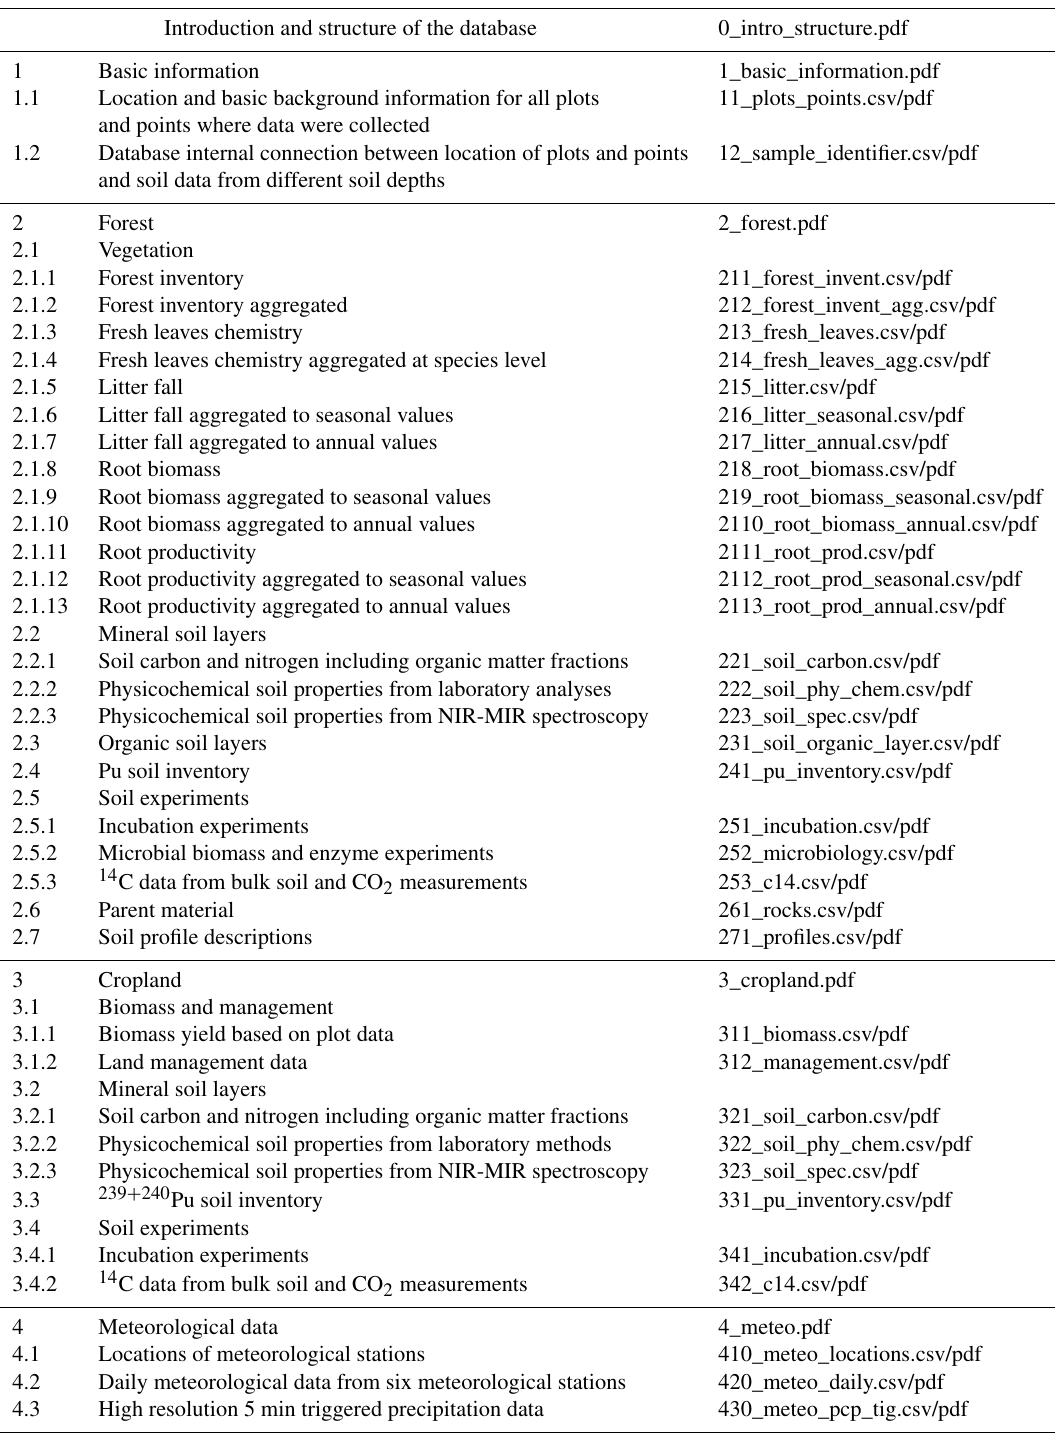
Table A2. Structure of the TropSOC database. For each topic a .pdf file is given that contains an overview of the available data on soil, vegetation, and weather collected for the investigated forest and cropland plots. Each dataset then comprises a data-containing .csv file and an additional metadata-containing .pdf file of the same